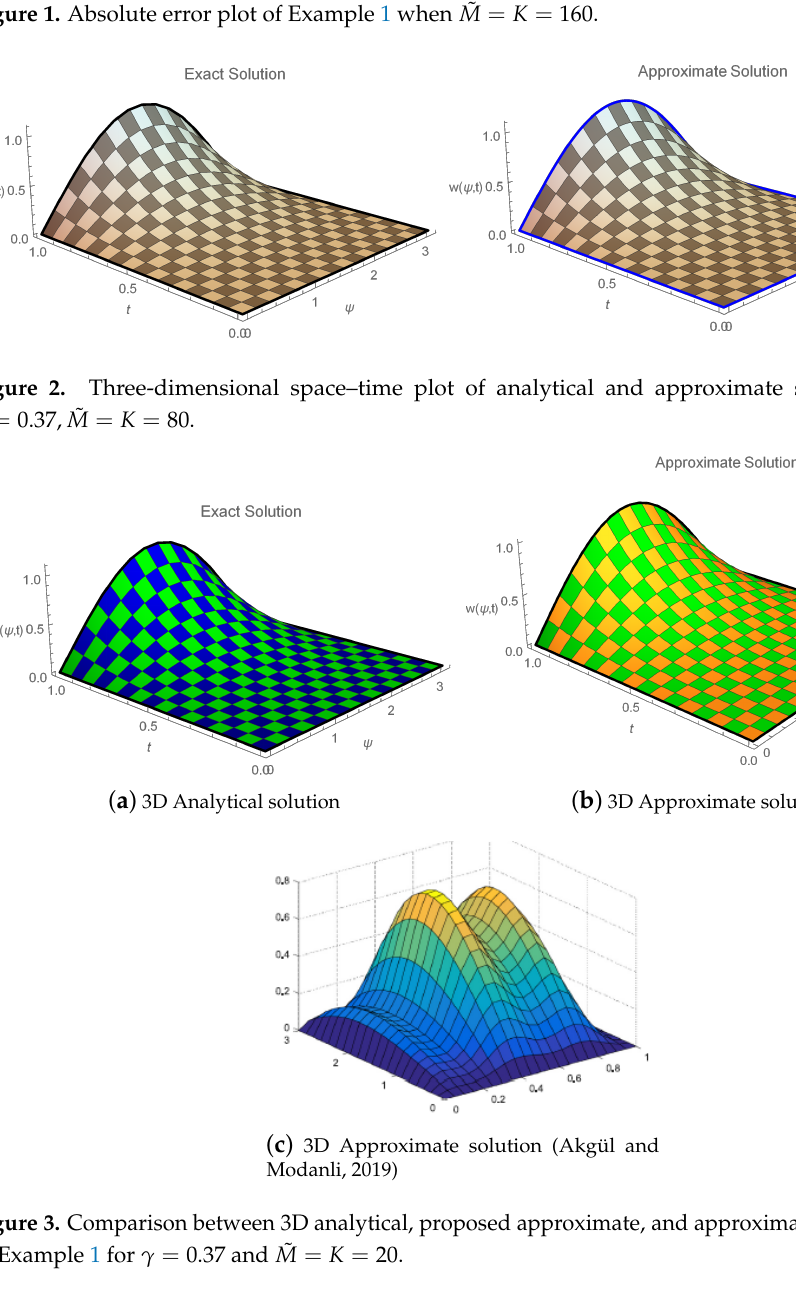
Figure 1. Absolute error plot of Example 1 when ˜ M = K = 160.